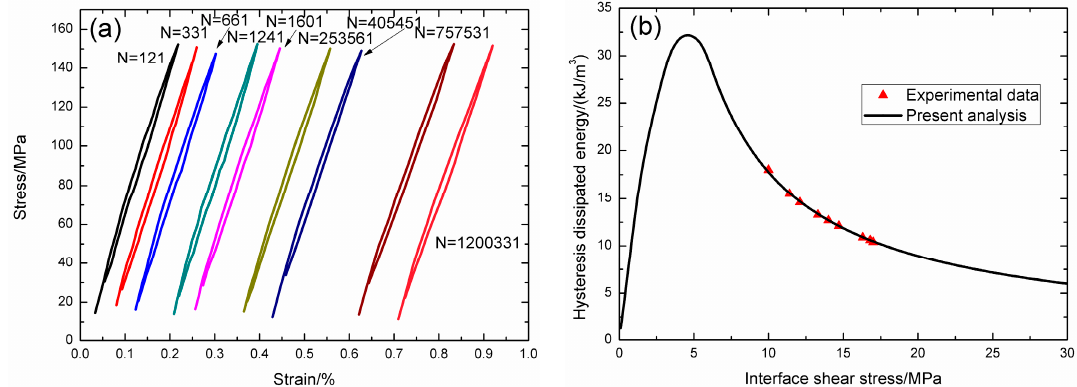
Figure 13. ( a ) The experimental fatigue hysteresis loops corresponding to different cycle number; and ( b ) the experimental and theoretical fatigue hysteresis dissipated energy versus interface shear stress curve of 2D woven SiC/SiC composite under σ max = 150 MPa at room temperature. Table 8. The interface shear stress of 2D woven SiC/SiC composite corresponding to different applied cycles under fatigue peak stress of σ max = 150 MPa at room temperature.